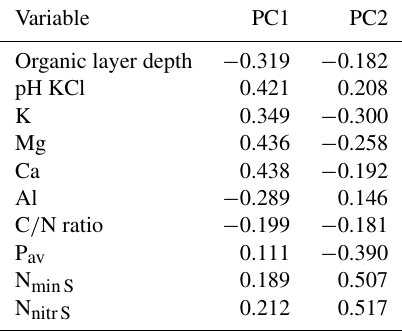
Table B1. Factor loadings of the variables in the PCA (Fig.